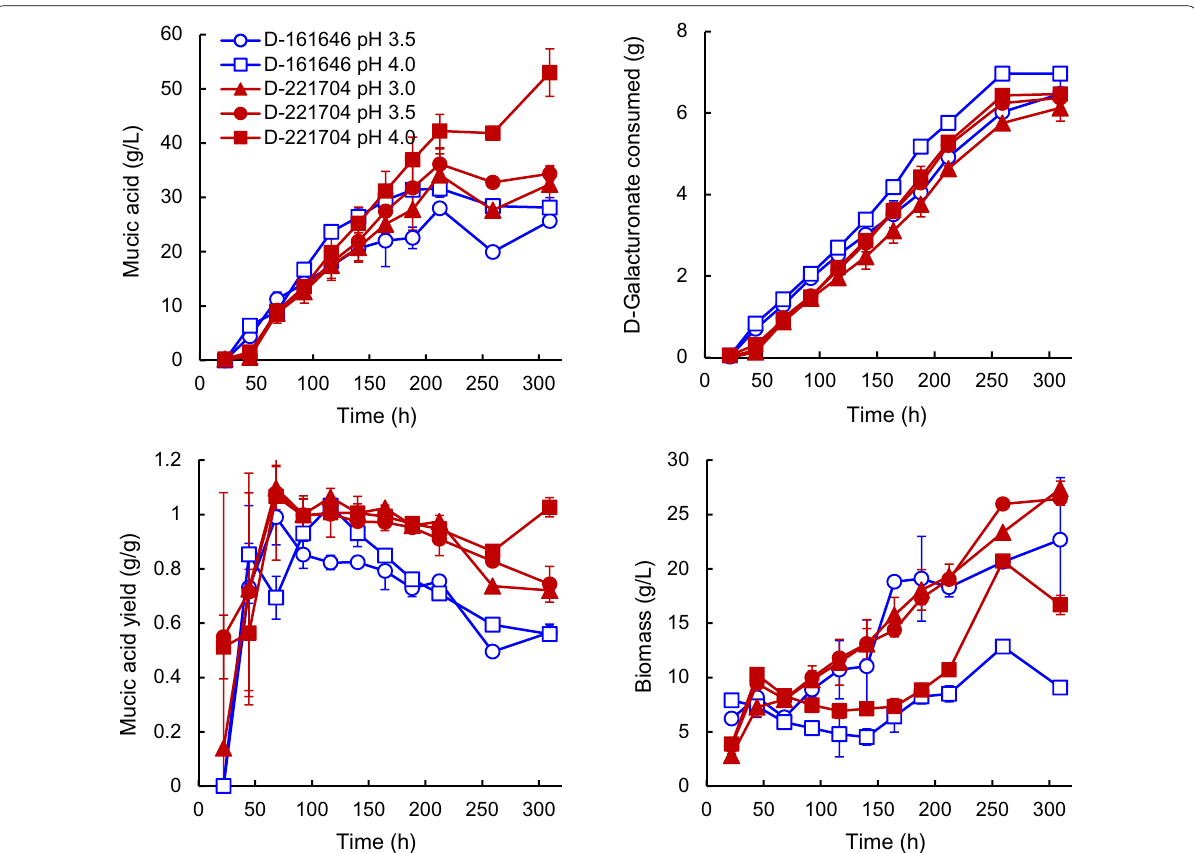
Fig. 1 Concentrations of mucic acid and biomass produced and total amount of galacturonic acid consumed, along with the yield of mucic acid on D-galacturonic acid for cultures of D-221704 (solid symbols) and D-161646 (open symbols) grown in fed-batch culture at pH 4.0 (square), 3.5 (circle) or 3.0 (triangle). Error bars represent standard error of the mean for 2 cultures ±